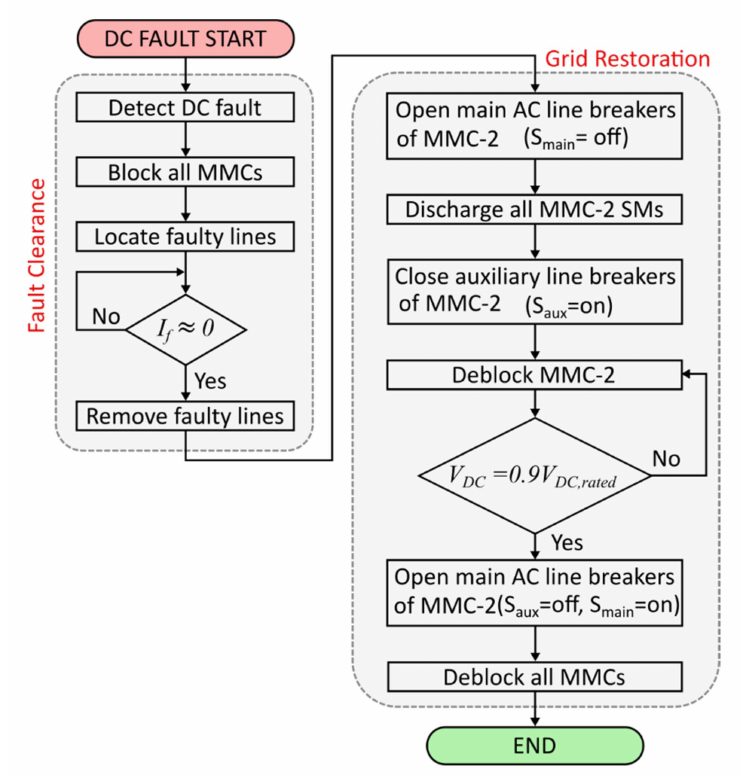
Figure 6. DC fault clearance and grid restoration